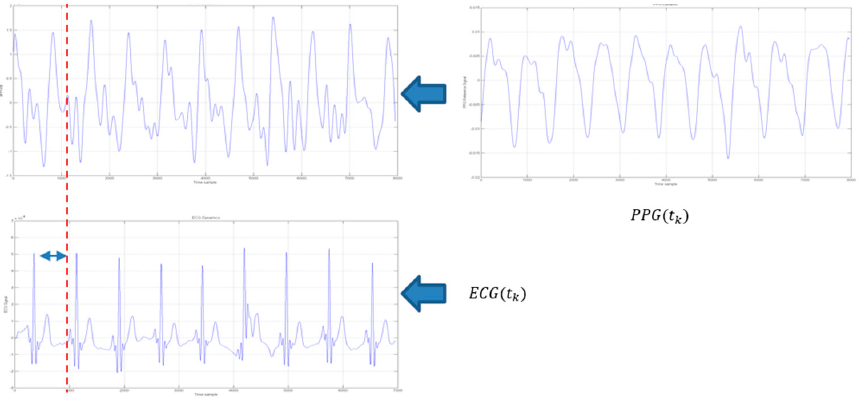
Figure 13. The PPG ( t k ) to ECG ( t k ) correlation diagram. The variable t k represent a time-onset of the segmented PPG/ECG waveforms. The first window on the left, reports the PPG first derivative ( dPPG ( t k ) / dt ) in the time-onset t k